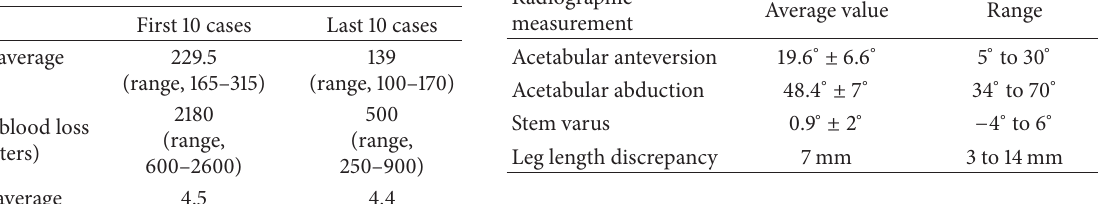
Table 1: Comparison of intraoperative and postoperative data for first ten unilateral versus last ten unilateral hip cases.